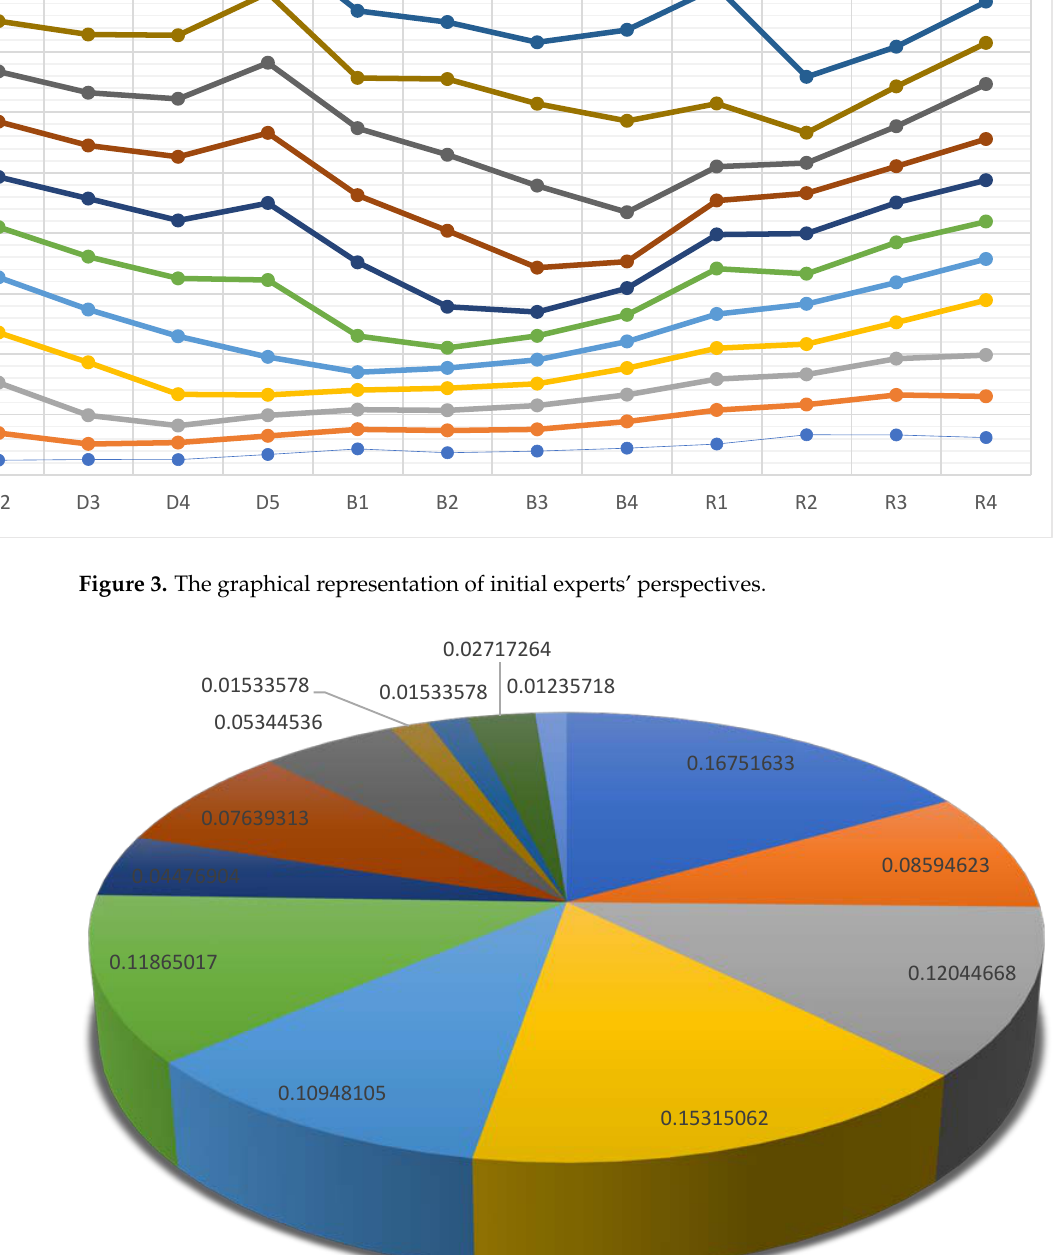
Figure 4. The weights representing decision-makers’ perspectives. In order to aid the process of decision-makers in uncertain conditions, the case study adopts the application of TOPSIS on four different service providers for DT according to the final weights for criteria. The four alternatives are: (1) Azure Digital Twins; (2) IBM; (3) CISCO; and (4) Oracle. The judgments of decision-makers are collected in a triangular neutrosophic scale and converted into numerical values. The aggregated decision makers’ judgments of alternatives for criteria are aggregated using Equation (7) and as mentioned in Table 7. Apply the three steps for TOPSIS as follows: normalization is applied using Equation (9); results are depicted in Table 8. The positive and negative regions are applied using Equations (10) and (11), with the results presented in Table 8. Compute negative and positive regions using Equations (12) and (13) to achieve the relative closeness using Equation (14), as mentioned in Table 9. Figure 5 shows the final ranking as follows: IBM, Azure DT, oracle, and CISCO. The final rankings can aid decision-makers to achieve ideal DT providers to achieve sustainability with respect to the challenges of IoT, AI, and in- dustry 4.0 technologies. Table 7. The aggregated decision-maker judgments for DT alternatives. Alterna- tives/Criteria